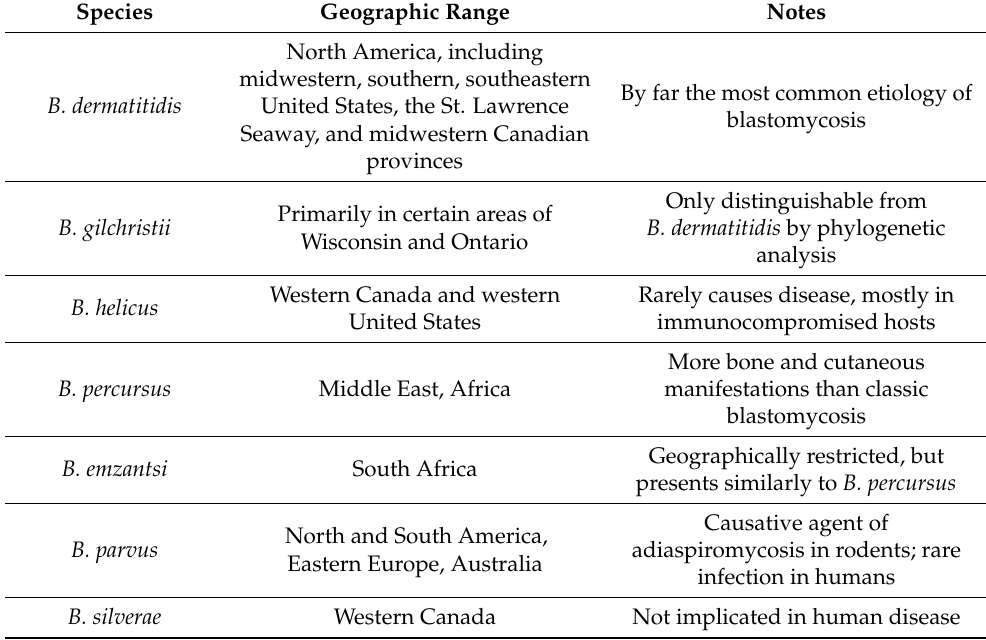
Table 1. Current species in the genus Blastomyces . Species Geographic